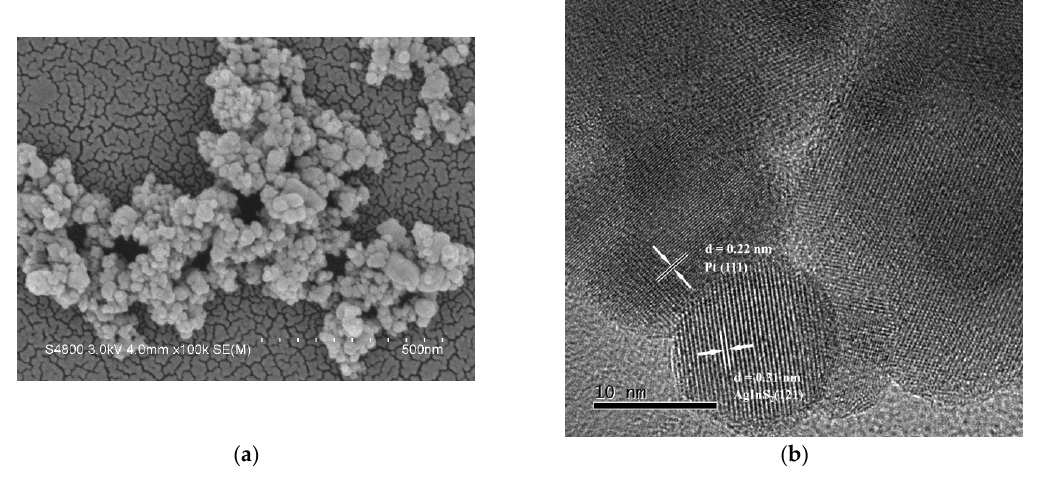
Figure 2. ( a ) SEM image and ( b ) TEM image of 1.0 wt% Pt/AgInS 2 photocatalyst.